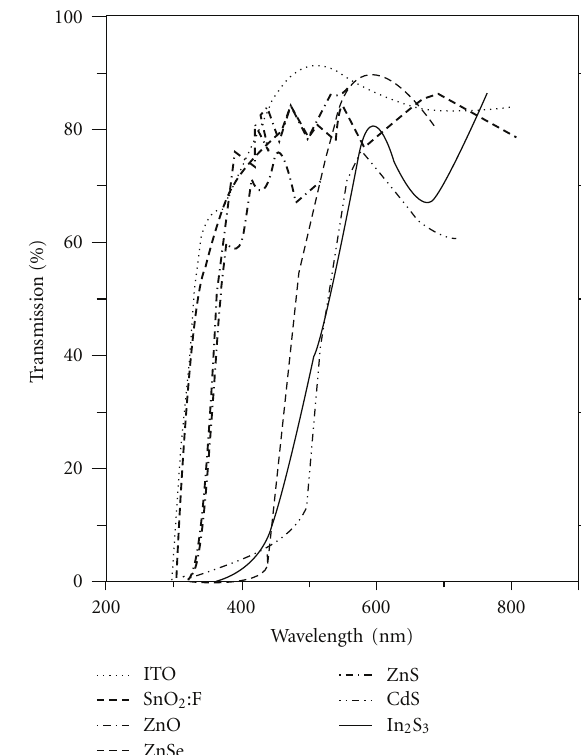
Figure 6: Optical transmission of di ff erent front contacts and bu ff er layers (from